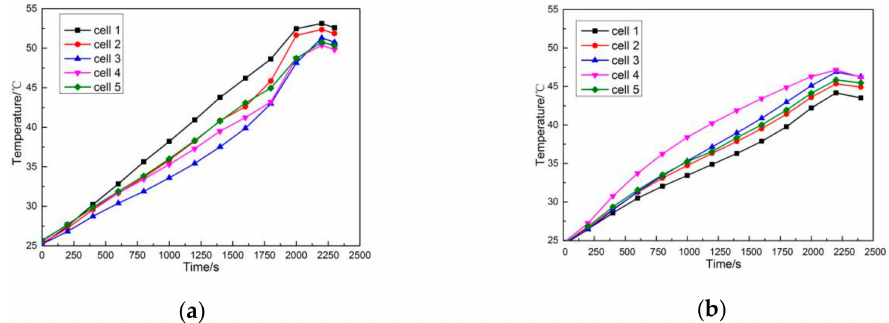
Figure 6. Temperature curve of battery under di ff erent graphite content of 1.5C discharge rate: ( a ) 0% expanded graphite (EG); ( b ) 5% EG.